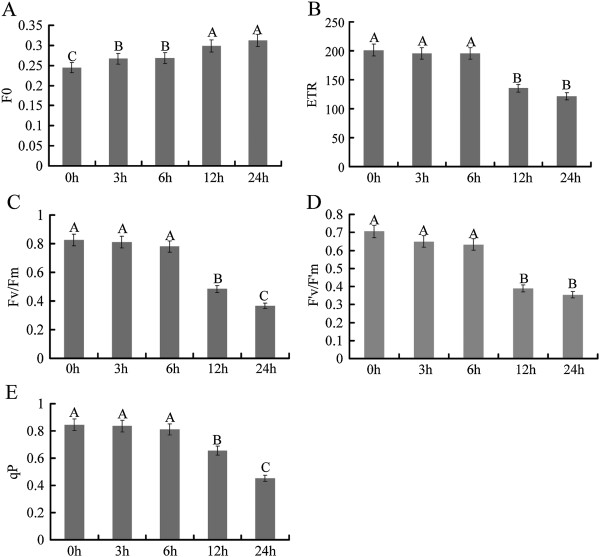
Changes in chlorophyll fluorescence at high temperatures. A: Fo represents minimum fluorescence. B: ETR represents electron transport rate. C: Fv/Fm represents the ratio of variable to maximal chlorophyll fluorescence. D: F′v/F′m represents fluorescence in the light ratio. E: qP represents photochemical quenching. 0 h indicates the control group without high temperature treatment. 3-24 h indicates different times of exposure to heat stress. Error bars represent standard error. Different letters on error bars indicate significant differences at P < 0.01.